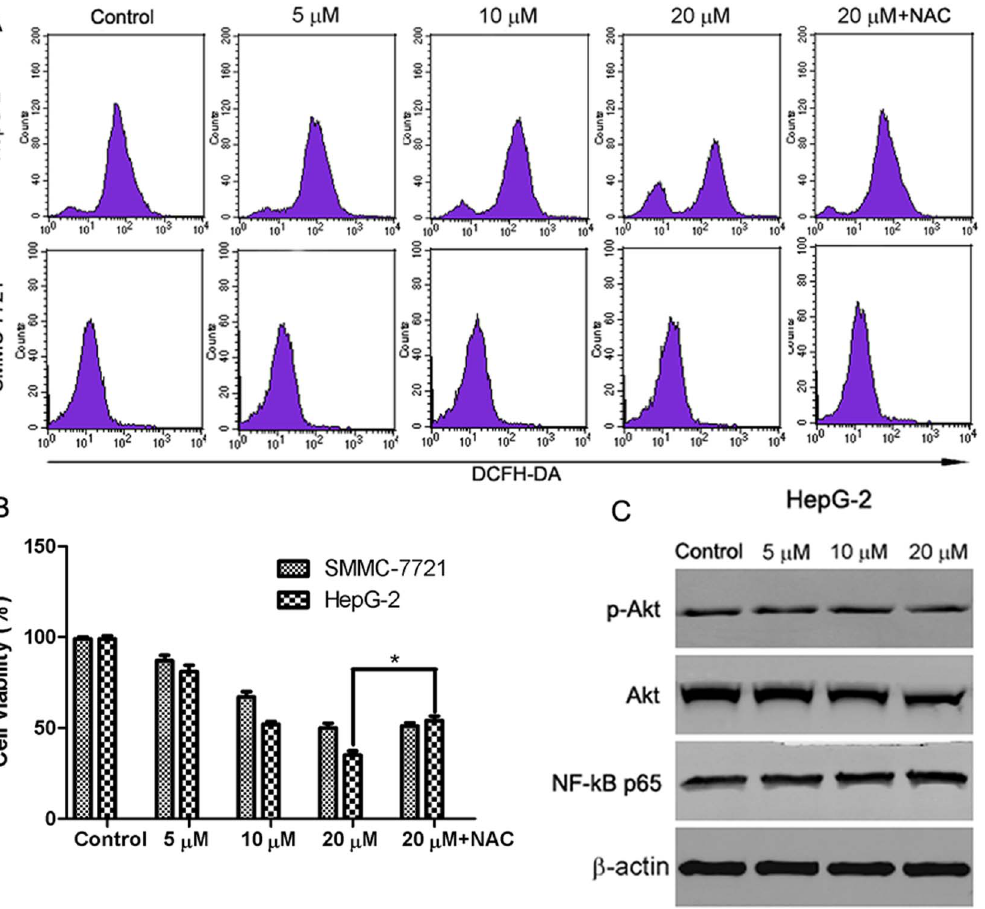
Fig. 7. The involvement of ROS/Akt pathway in abieslactone-induced HepG2 cell apoptosis. (A) HepG2 and SMMC7721 cells were treated with different concentrations of abieslactone or ROS scavenger (NAC 10 mM), and then ROS was measured by DCF fluorescence analysis. The increased fluorescence of DCF was determined as the increased intracellular ROS accumulation. (B) HepG2 and SMMC7721 cells pretreated with 10 mM NAC for 1 h were incubated with 20 m M abieslactone for 24 h, and cell viability was determined by MTT assay. * P , 0.05 vs . the untreated control. (C) The effect of abieslactone on the expression of p-Akt, Akt and NF-kB p65 proteins in HepG2 cells. b -actin was used as a